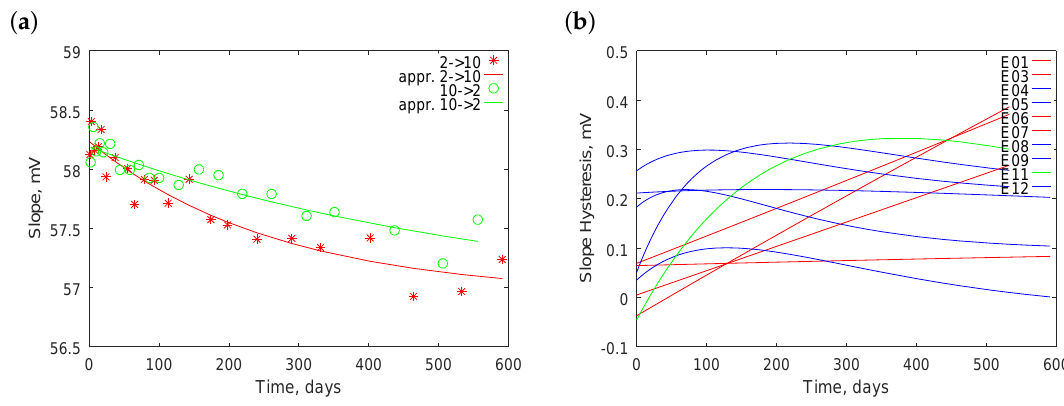
Figure 10. Illustration of dependence of hysteresis effect on electrode slope: ( a ) example of electrode E11; and ( b ) hysteresis of electrodes E01–E12.